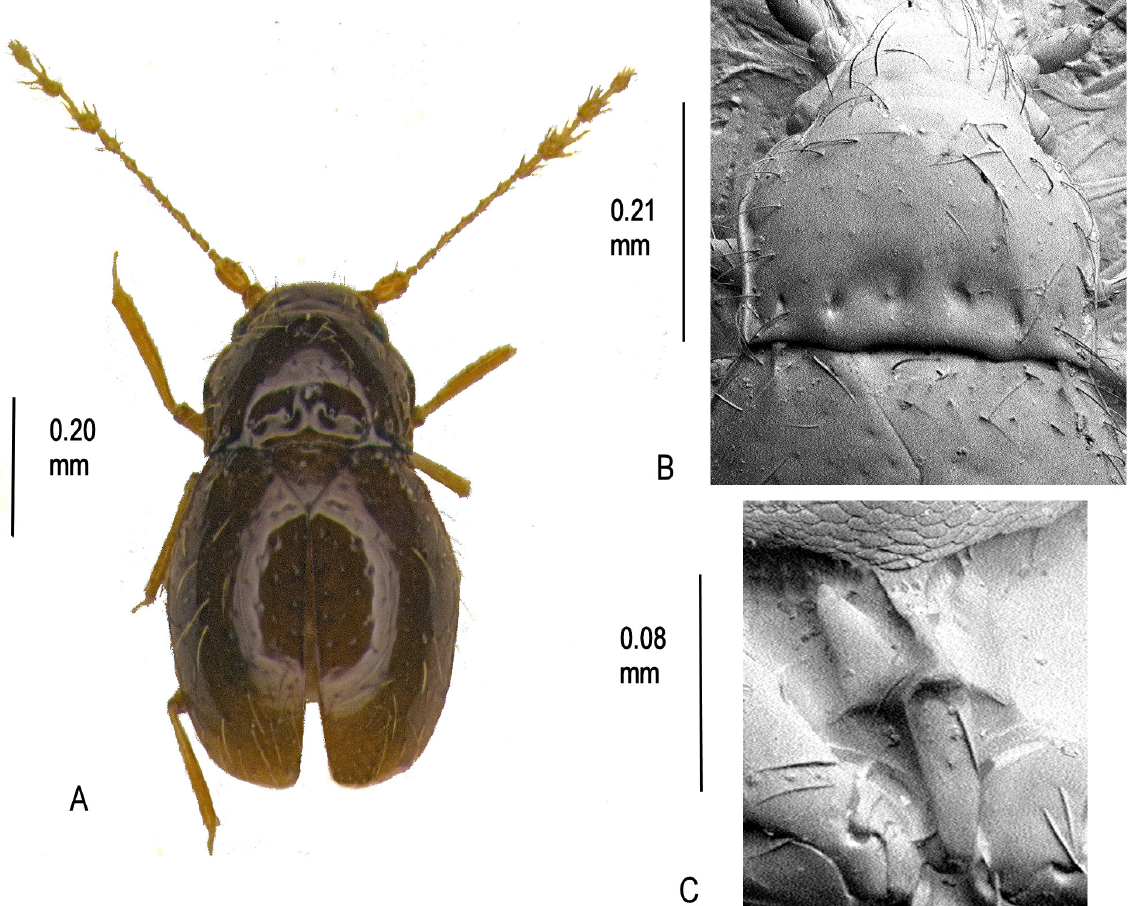
Fig. 39 . Cissidium pinense sp. nov. A . Habitus. B . Pronotum, × 445. C . Mesoventrite showing median process of collar, mid-keel and keel, ×